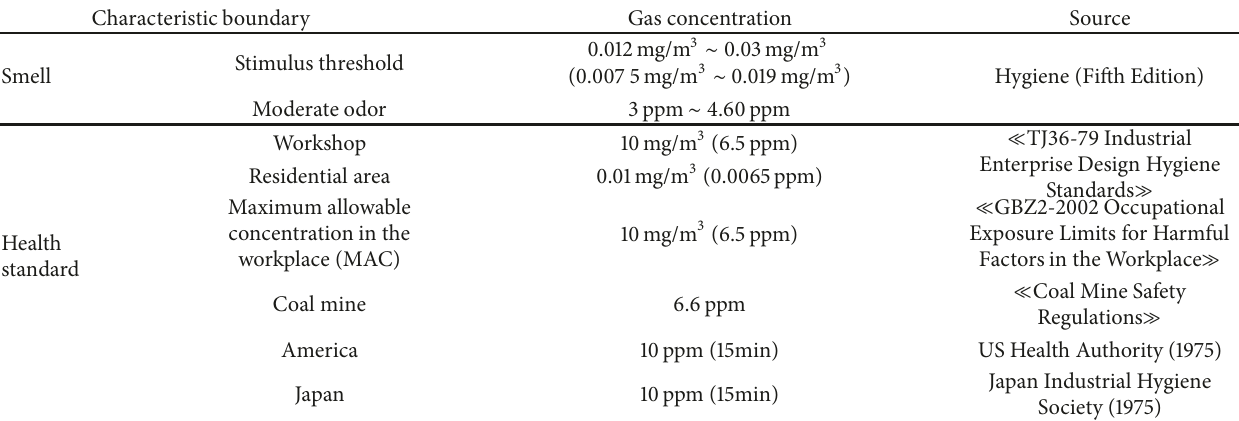
Table 1: The environmental standards of H 2 S of difference